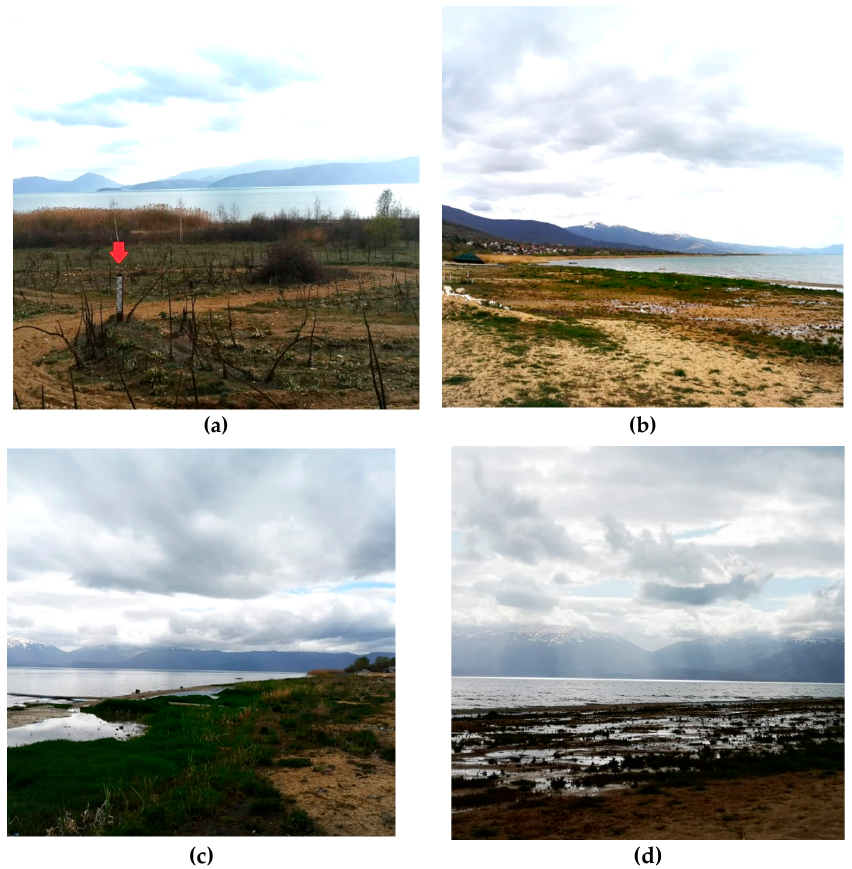
Figure A1. The current state of Prespa Lake´s shore in Pretor (spring 2022). The shoreline has receded for several hundred meters over the past few decades. ( a ) View to SW. A water level gauge (red arrow) can be seen that was in use a few decades ago, now showing where the water frontline once was. ( b ) View to S. ( c , d ) View to W to Mount Galichica. Source: N.A.